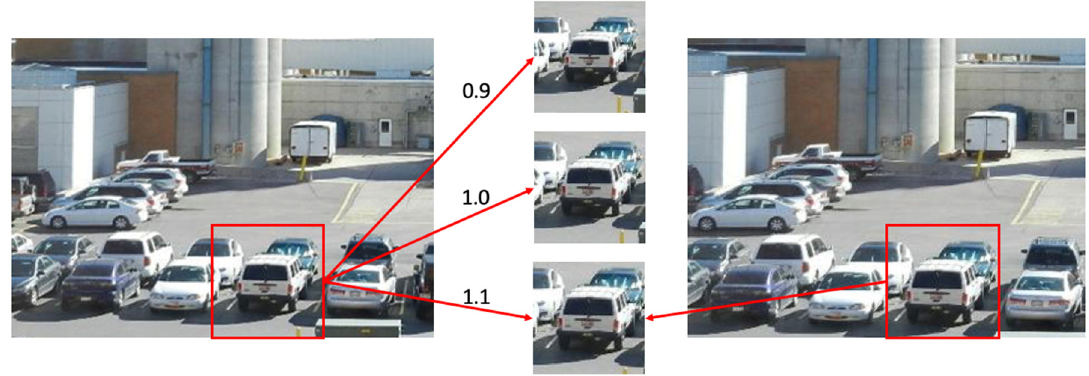
Figure 2. Illustration of how generating scaled FRIs achieves scale invariance. FRI in the first image (left) is scaled to 0.9, 1.0, and 1.1. The one scaled to 1.1 is determined to be the best match to the FRI in the second image.